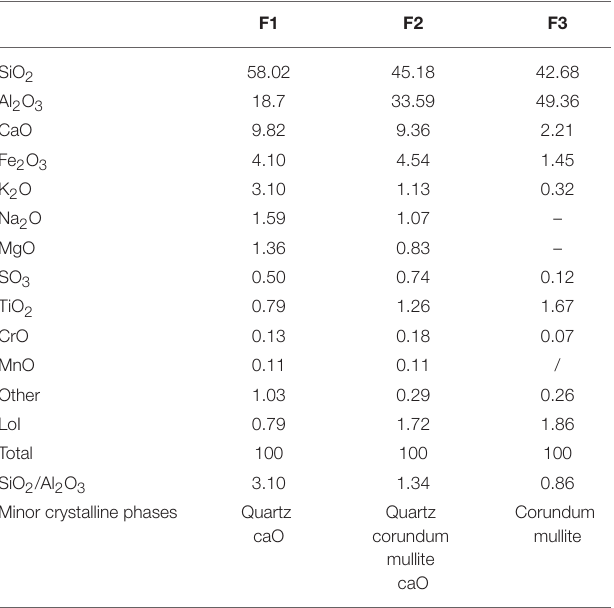
TABLE 1 | Bulk chemical composition of the coal fly ash studied. TABLE 2 | Mechanical strength of alkali-activated paste prepared with ground or